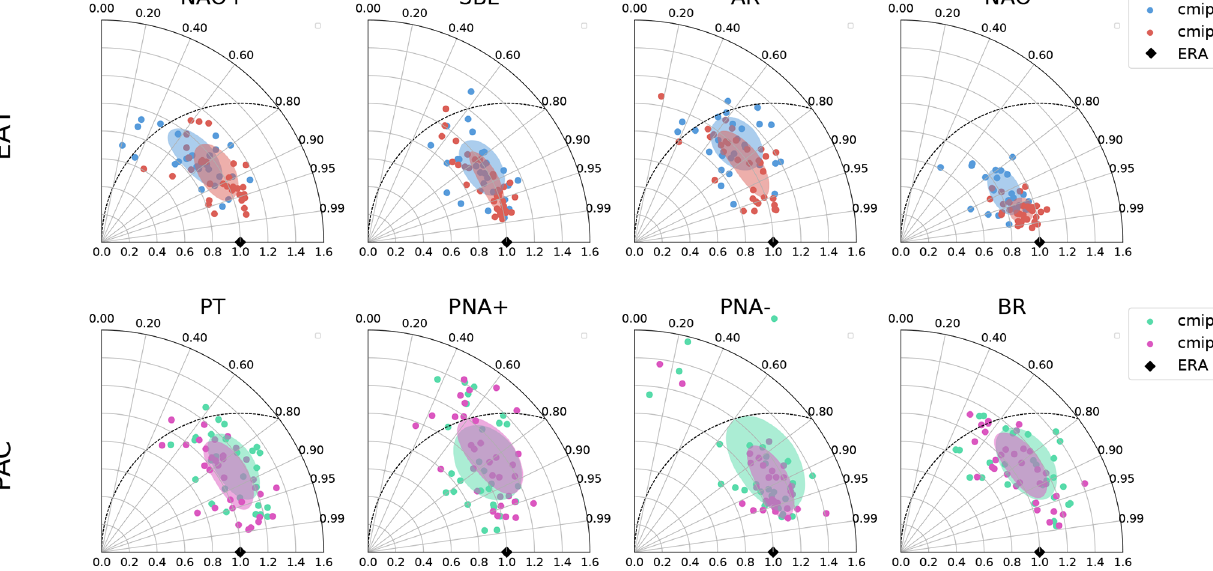
Figure 2. Taylor diagrams showing the agreement between simulated and observed regime patterns for CMIP5 (blue and green) and CMIP6 (red and pink) models. The shaded ellipses are used to indicate the overall ensemble performance; they are centred on the ensemble mean and have semi-axes equal to the ensemble standard error. The simulated patterns are those obtained from the computed regimes of the historical simulations in the common period 1964–2005. The observed patterns are those computed from the